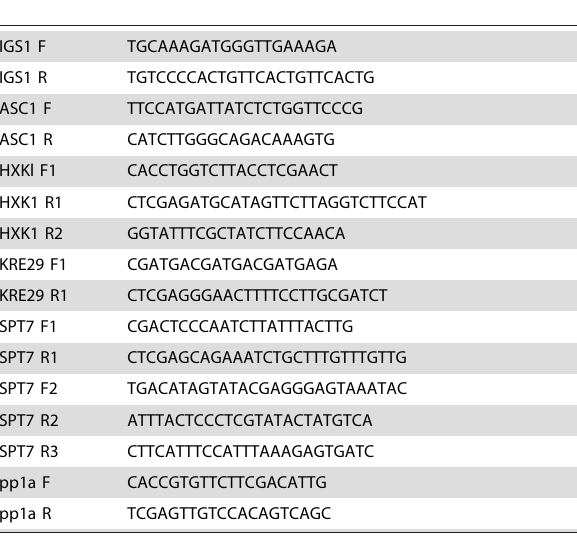
Table 1. Oligonucleotides used in this